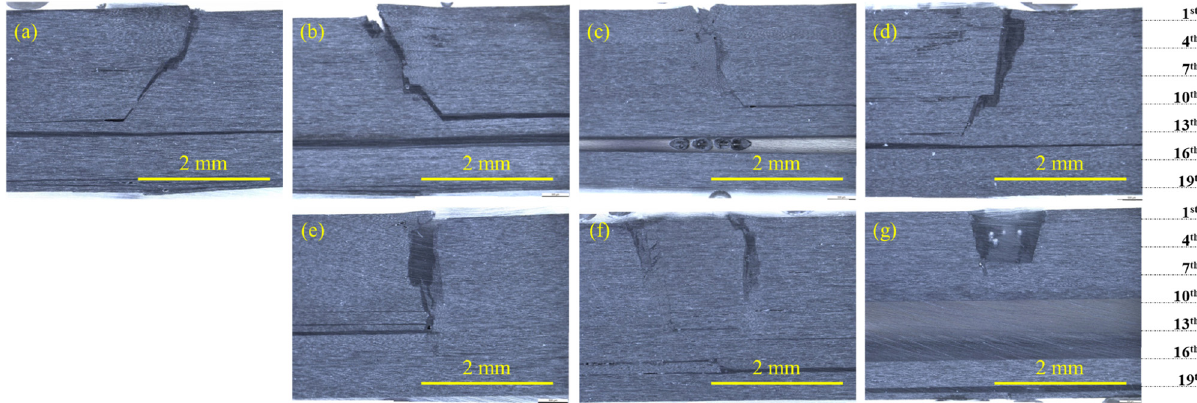
Figure 11: Cross - section observation on the flexural fracture behavior of CF/epoxy laminates with fiber breakage in different layers after 95% stress cyclic bending texts: ( a ) original, ( b ) 1st layer, ( c ) 4th layer, ( d ) 7th layer, ( e ) 13th layer, ( f ) 16th layer, and ( g ) 19th